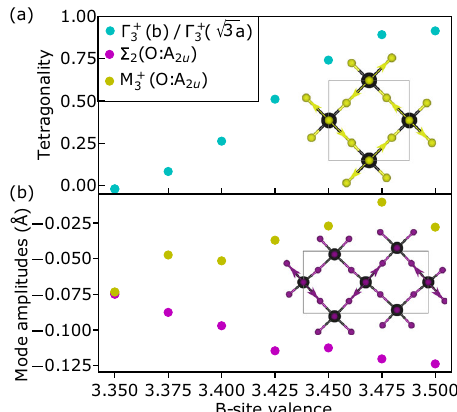
Fig. 3 Parameters extracted from Rietveld re fi nement against high- resolution synchrotron X-ray powder diffraction (SXRD) data on AMn 7 O 12 . a Symmetrised strain ( Γ þ metric tetragonal symmetry is observed for a B-site valence around 1 doping levels. b The orbital ordering distortion modes transforming as irrep. M þ and Σ 2 of Pm (cid:1) 3 m with Jahn-Teller distortion characters as shown in the 3 insets. Large uncertainties are associated with determining M þ re fi nements it is highly correlated with octahedral tilt displacements (M þ